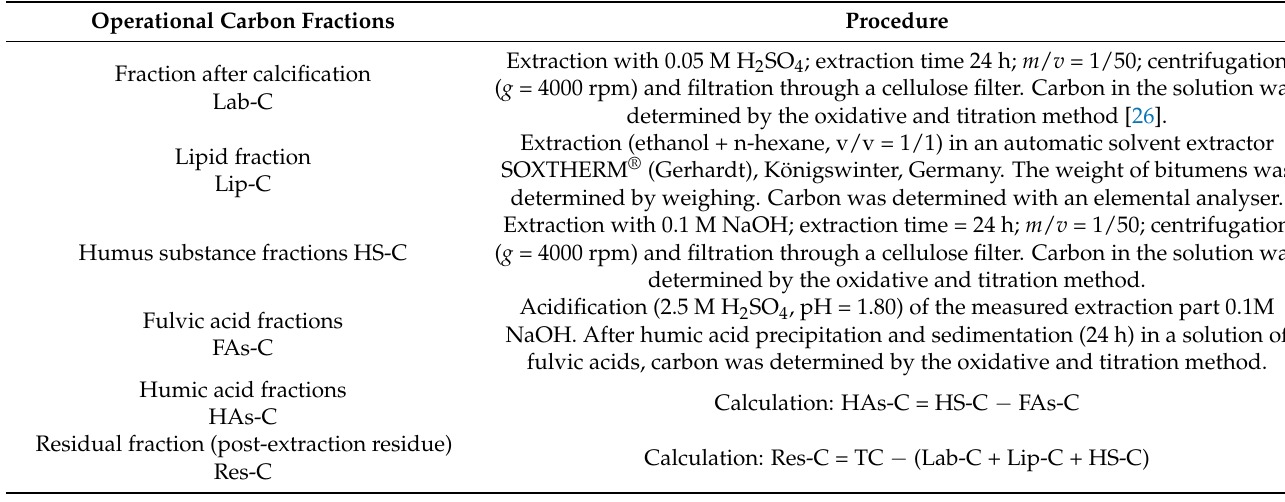
Table 1. Procedure for obtaining carbon